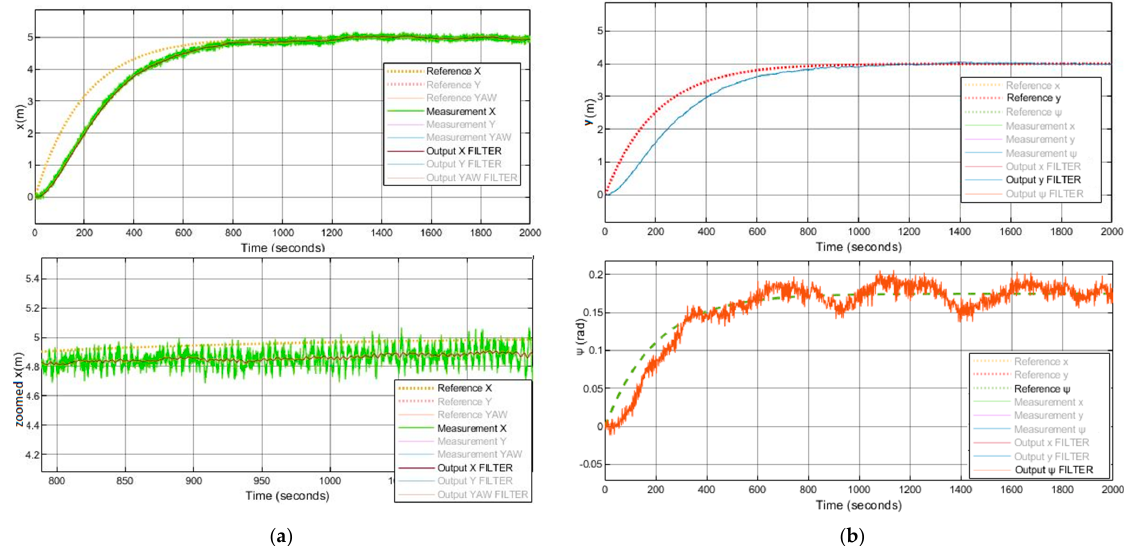
Figure 10. ( a ) System with classical controller control results with waves, position x. ( b ) System with classical controller control results with waves, position y and 𝜓 .